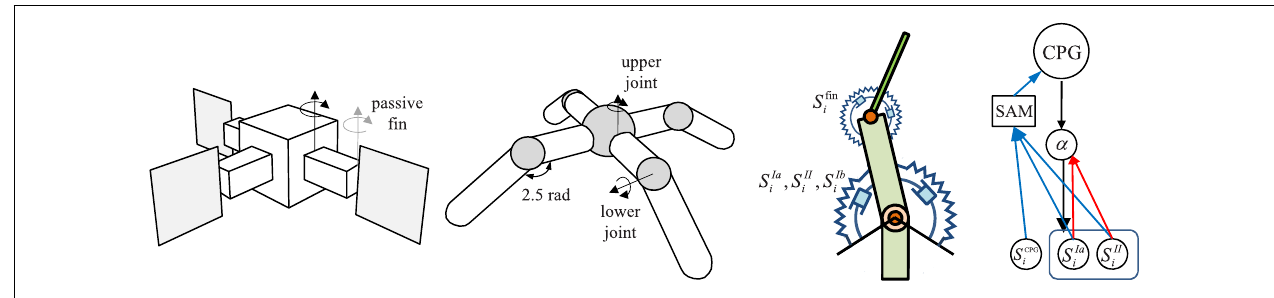
parental limb in order to facilitate the movement of the joint angle within a specified range, up to where the stretched angle of two antagonistic torsional muscles at the neutral position of the joint becomes double the rest angle. The swimmer uses fin angles, S fin for CPG sensor input ( S CPG ), whereas the quadruped uses muscle force sensors S Ib .